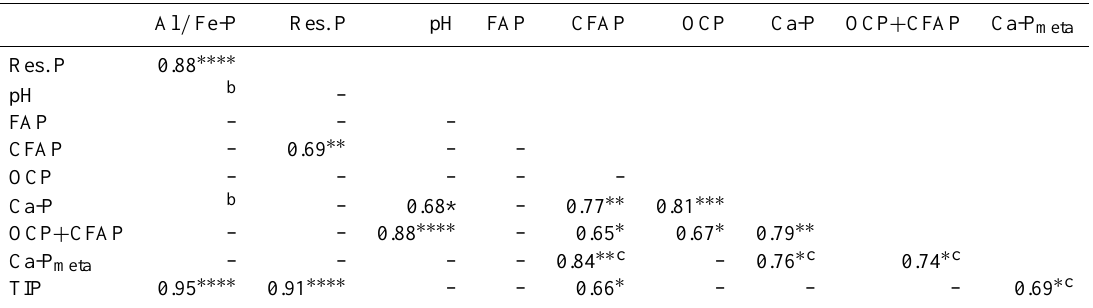
Table 4. Correlation coefficients (for p < 0.05) between concentrations of P fractions, OCP, CFAP, FAP and pH in sediments analysed for particular Ca-P species. a Al / Fe-P Res. P pH FAP CFAP OCP Res.